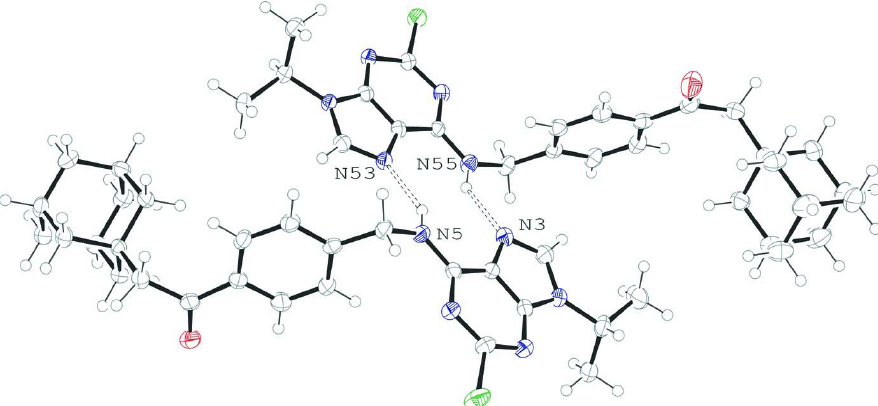
Part of the crystal structure of the title compound, showing the hydrogen bonding (dashed